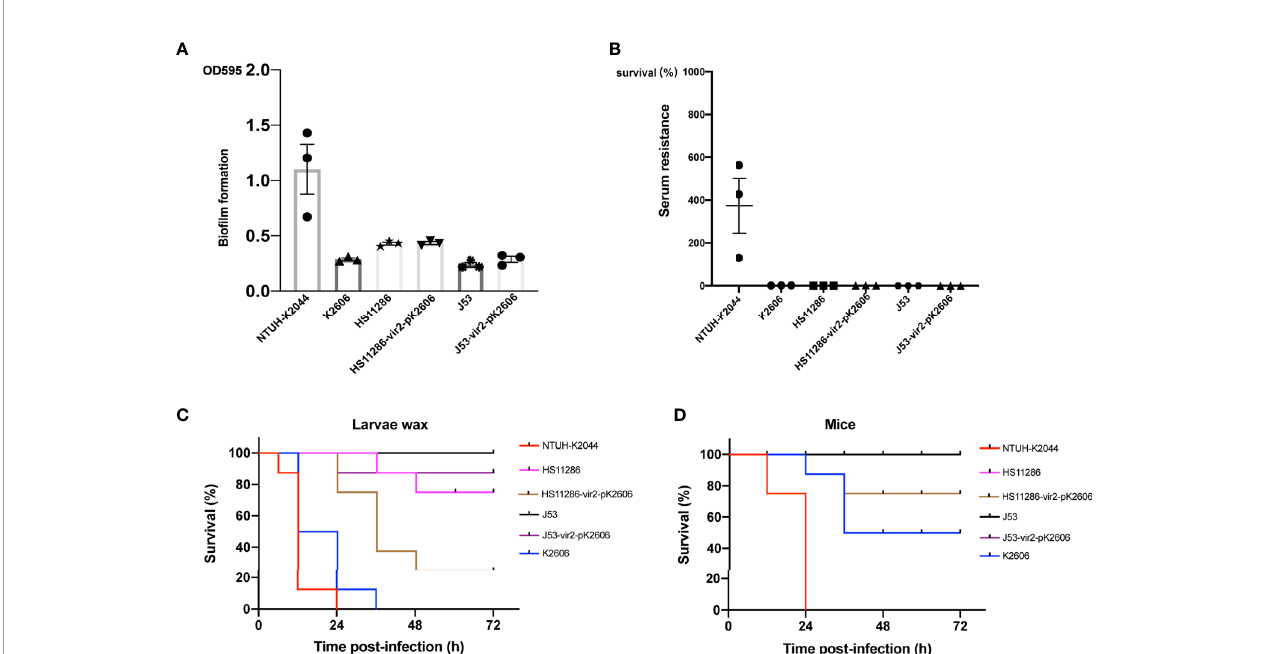
FIGURE 2 | The virulence phenotype of strains and transconjugants. The bio fi lm formation (A) and serum resistance (B) of K2606, HS11286, J53, HS11286-vir2- pK2606, and J53-vir2-pK2606. Hypervirulent strain NTUH-K2044 was used as a positive control. An unpaired two-sided Student ’ s t-test was performed for parental strain and its transconjugant. Each data point was repeated three times (n = 3). Data are presented as the mean ± s.e.m. No signi fi cant difference (P>0.05) was observed between HS11286 and HS11286-vir2-pK2606, and between J53 and J53-vir2-pK2606. The virulence level of different strains and their transconjugants as depicted in a larvae wax infection model (C) and a mouse infection model (D) . Survival of mice (n = 8) infected by each K. pneumoniae strain at 72 h is shown. Hypervirulent NTUH-K2044 was used as a positive control. A log-rank (Mantel – Cox) test was performed for the indicated curves. A signi fi cant difference (P < 0.0001 in both C, D ) was observed between HS11286 and HS11286-vir2-pK2606, and between J53 and